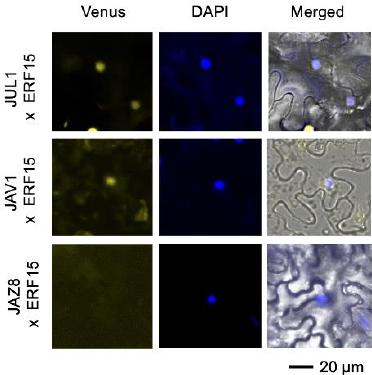
6 of 12 Figure 4. In vitro JUL1 ubiquitination activity on JAV1 and JiTFs (JiTF3 [ERF15], JiTF5 [bZIP5] and JiTF7 [ORA59]) as substrates. ( A ) Biotinylated JiTFs and JAV1 proteins were incubated with FLAG- tagged ubiquitin (FLAG-Ub), UBCH5b (E2) and AGIA-tagged JUL1. ( B ) Likewise, biotinylated JAV1 proteins were incubated with FLAG-Ub, UBCH5b, and AGIA-tagged JUL1 in the presence of AGIA- tagged GFP or ERF15. The incubated reaction mixtures were immunoprecipitated using streptavi- din-linked magnetic beads, subjected to SDS-PAGE, and probed with an anti-FLAG-HRP (FLAG- Ub) antibody. The smeared signals indicate possible ubiquitinated substrate proteins. 2.5. In Planta Complex Composed of JAV1, JUL1 and ERF15 Finally, in order to confirm the in planta interaction of ERF15 with JUL1 and JAV1, we performed bimolecular fluorescence complementation (BiFC) assays. Concomitant ex- pression of JUL1 or JAV1 fused to the N-terminal fragment of Venus (nVenus) and ERF15 fused to the C-terminal fragment of Venus (cVenus) in Nicotiana benthamiana leaf cells re- sulted in fluorescent signals from the reconstructed YFP proteins in the nuclei (Figure 5).